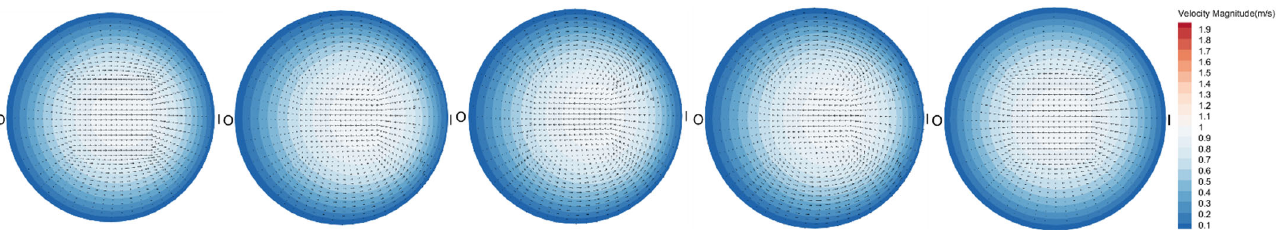
Figure 16. The velocity magnitude and the velocity vectors at the five sections of the U ‐ shaped chan ‐ nel. The inlet velocity of 0.5 m/s. The temperature boundary condition is: 300 K on the wall and 283 K of the incoming fluid at the inlet.